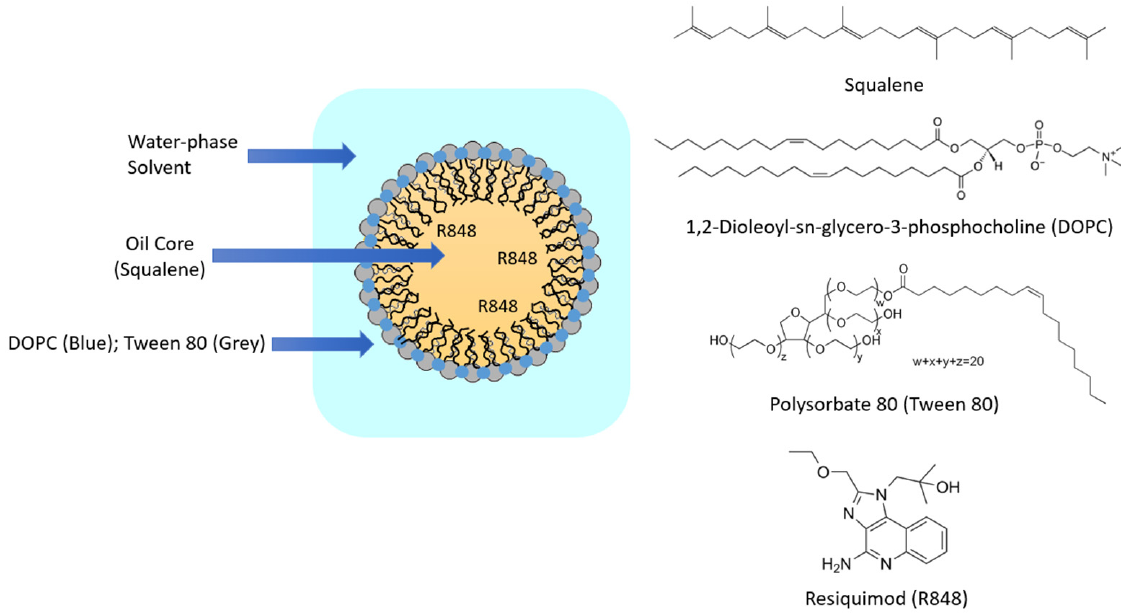
Figure 1. Structure of R848-loaded squalene emulsion and chemical components.